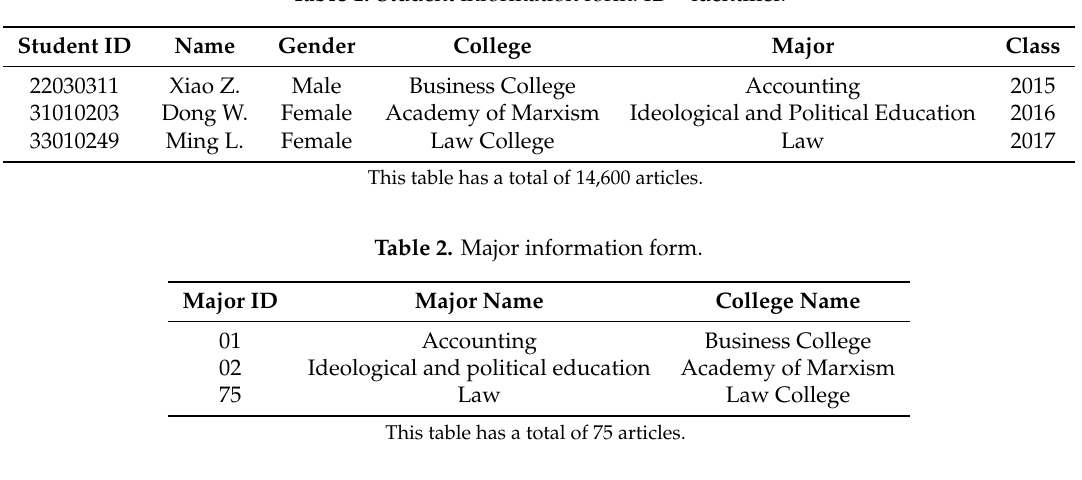
Table 1. Student information form. ID—identifier.